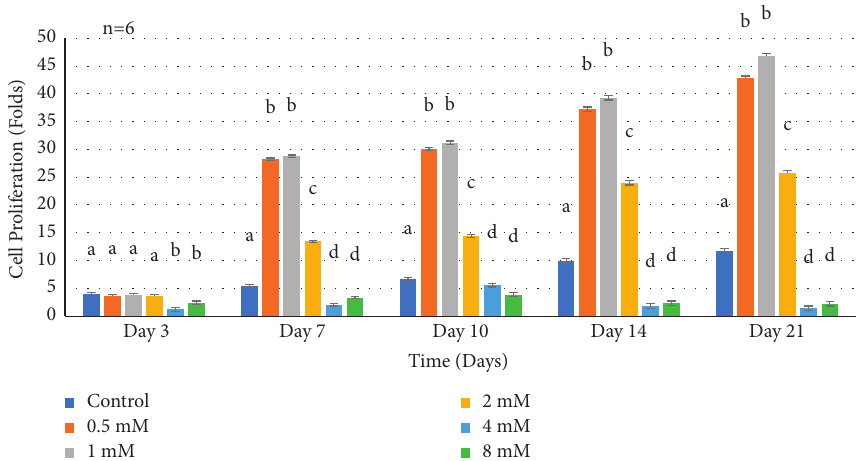
Figure 2: Histogram showing proliferation rates of normal human dental pulp cells in media with supplemental Mg 2+ concentrations. Note: normal human dental pulp cells were cultured with media containing supplemental Mg 2+ concentrations 0.5mM, 1 mM, 2mM, 4 mM, and 8mM and 0 mM as the control group for time periods of 3, 7, 10, 14, and 21 days. Folds were calculated by dividing the cell numbers at each time interval by the seeded cell number for each condition. Cell number was calculated by using optical density measurement results dividing the constant number (per million cells’ optical density). The data are presented as means of six replicates with error bars indicating the standard deviation. Groups labeled with different letters differ statistically as compared to the control group and other study groups ( P < 0 .